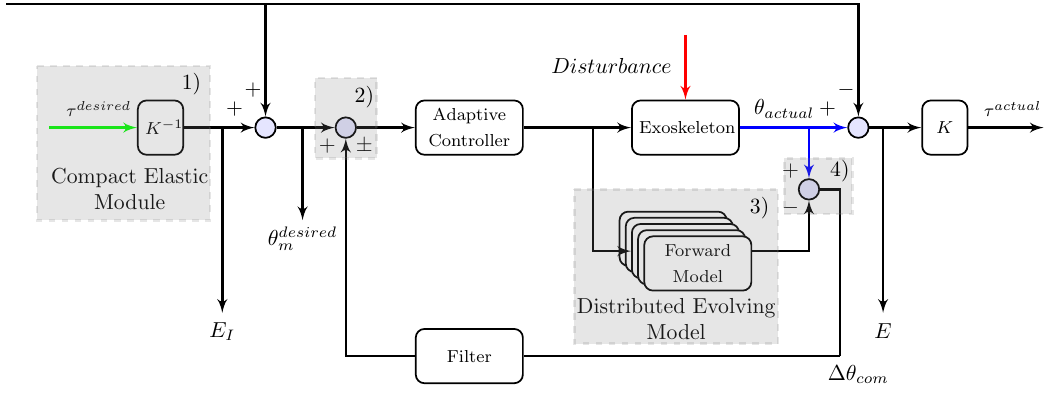
Figure 9. General representation of the evolving internal model